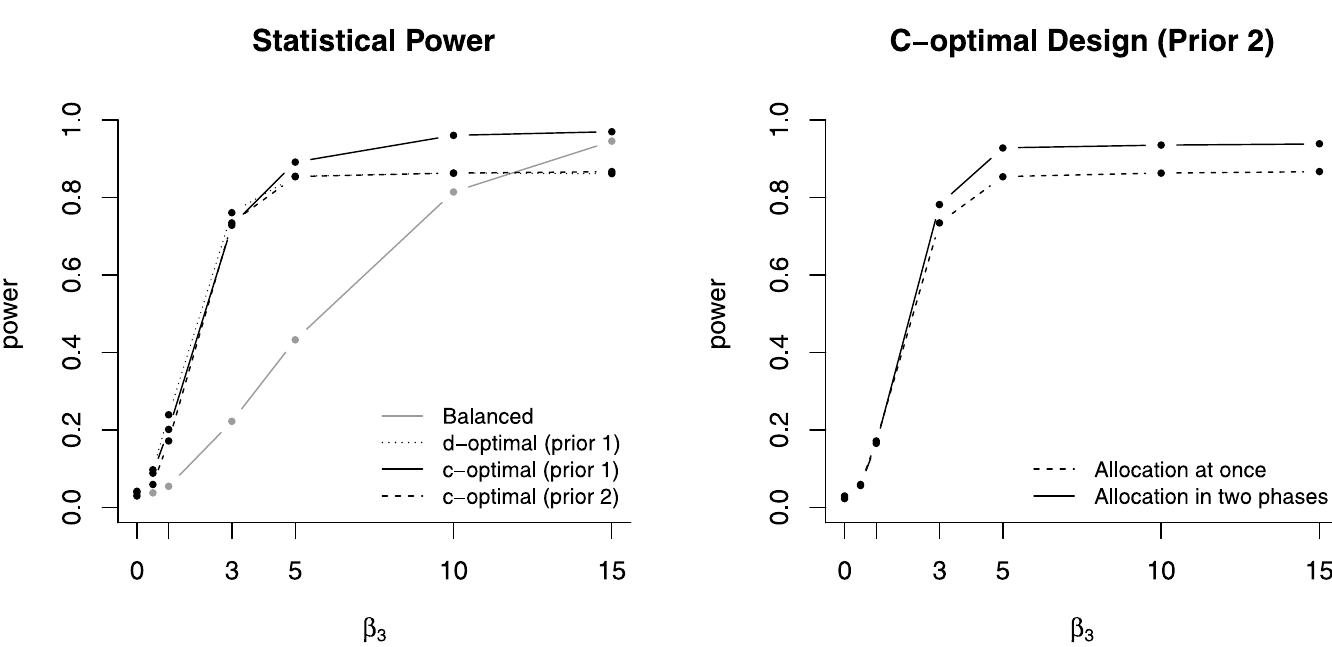
Fig 8. Statistical power. The figure on the left demonstrates that the c-optimal design and d-optimal design outperform the balanced design when β 3 is relatively close to the null value 0. The figure on the right demonstrates that the c-optimal design with prior 2 can be improved by the adaptive design.